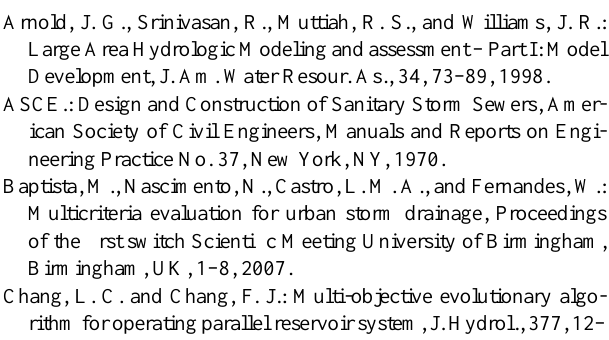
Figure 10 may be used for selection of the best